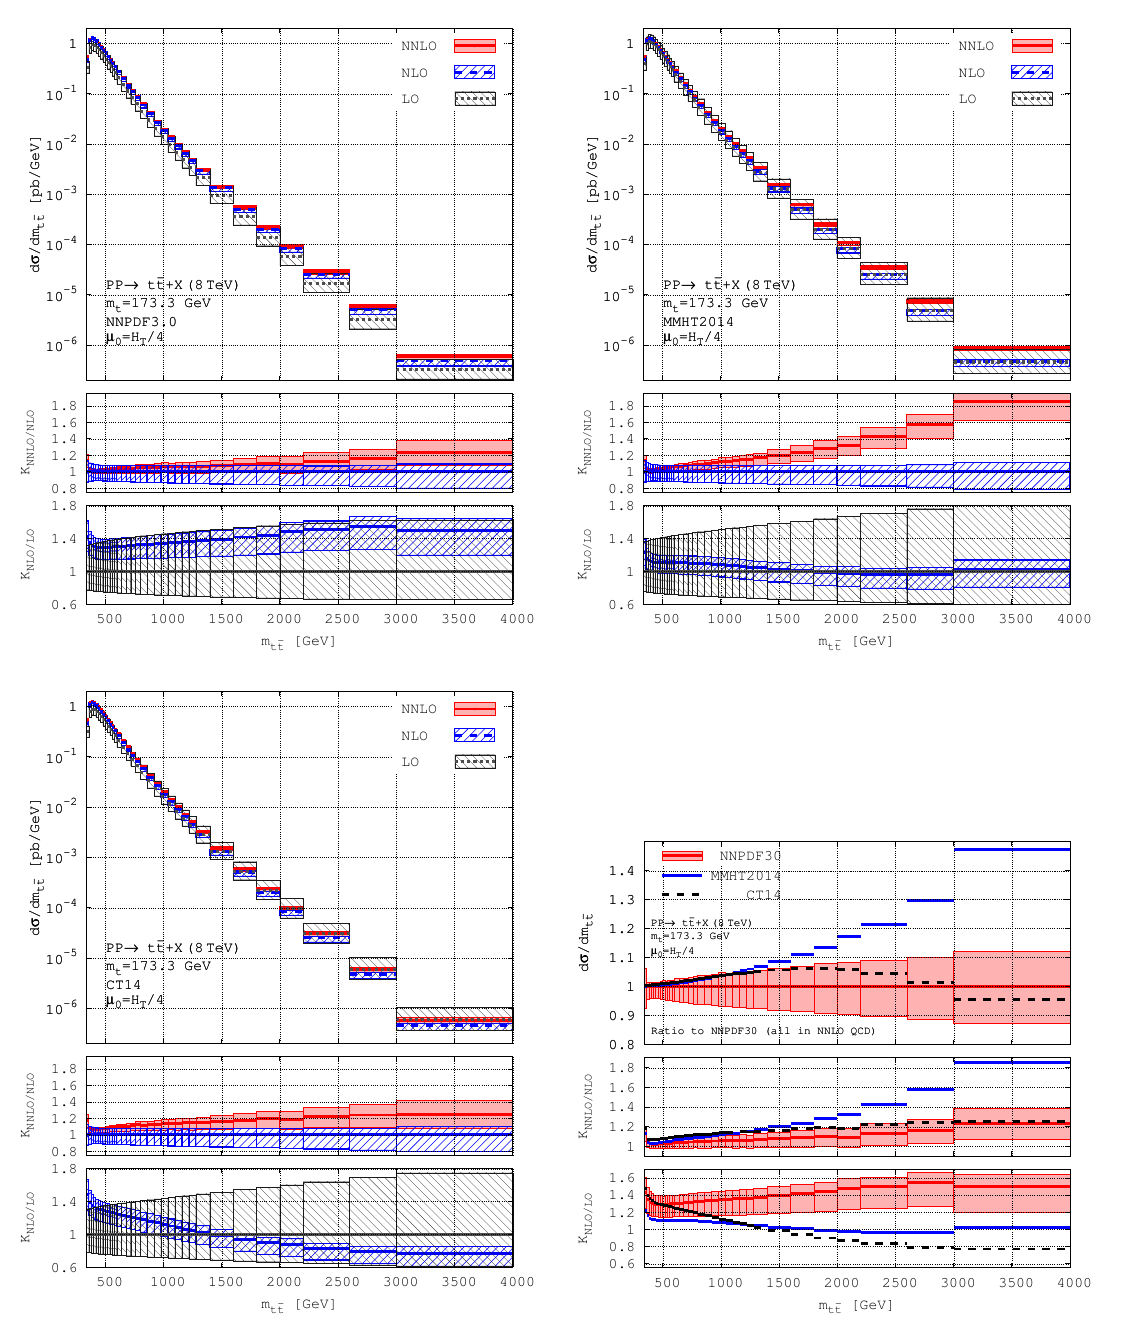
Figure 8 . As in (cid:12)gure 7 but for the m